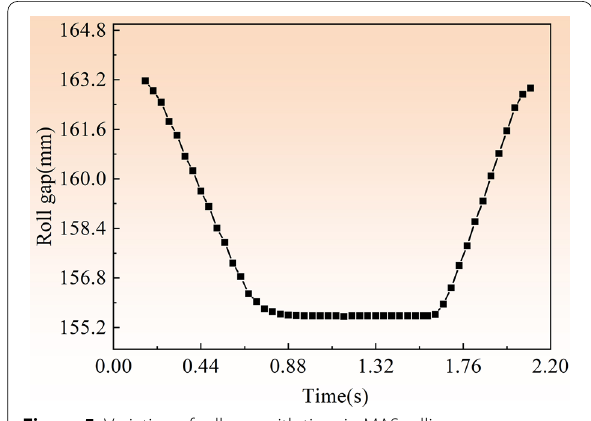
Figure 5 Variation of roll gap with time in MAS rolling